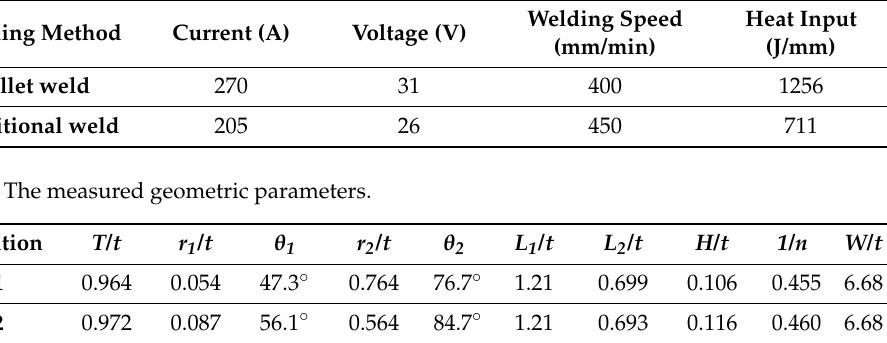
Table 2. The welding condition.